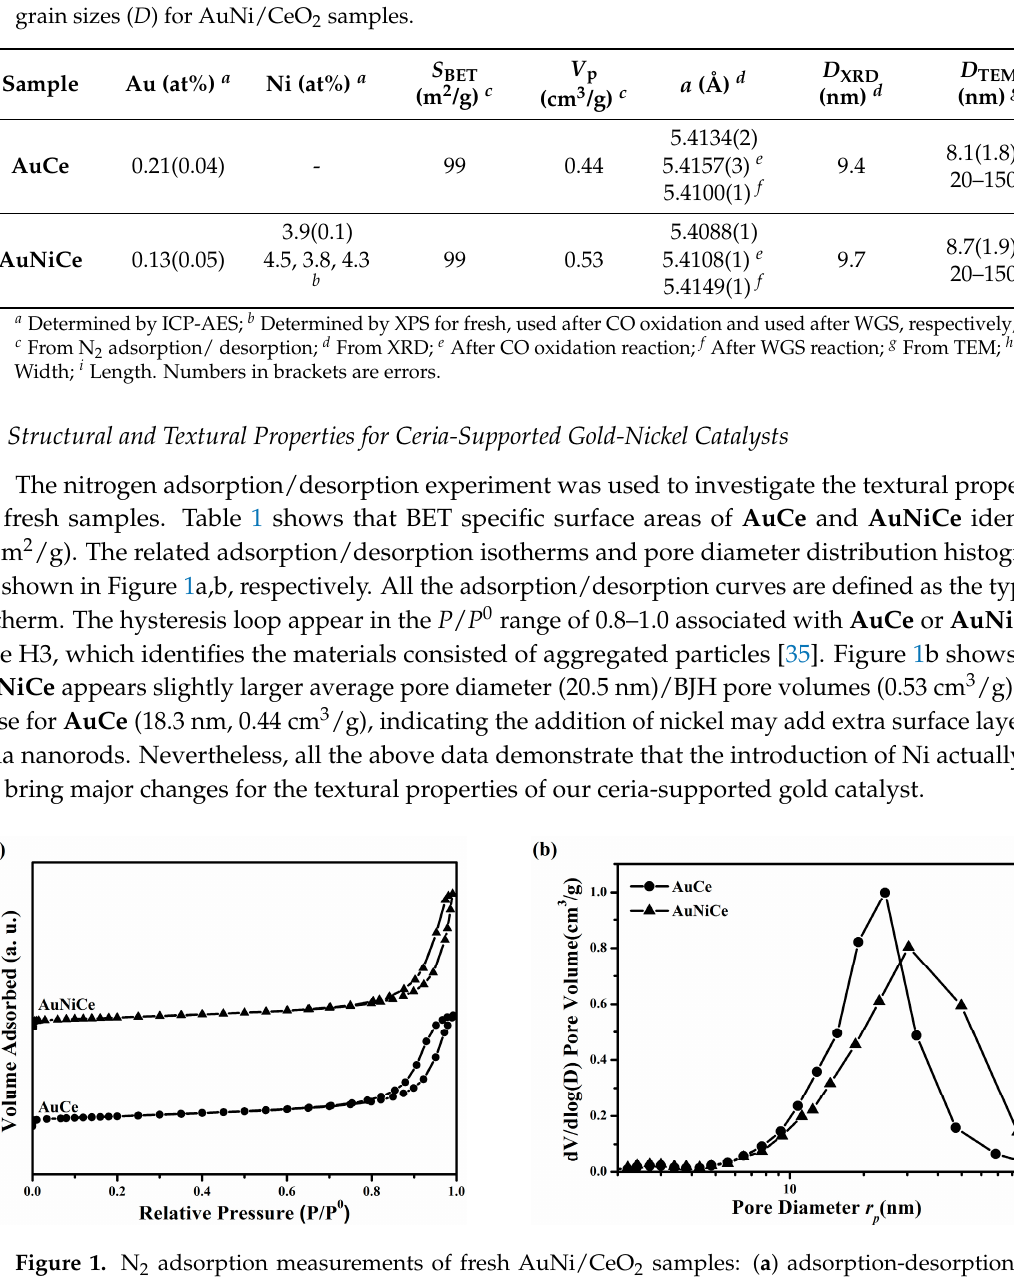
Table 1. Au and Ni bulk concentration, atomic ratios (Ni/(Ni + Ce)) on the surface, BET Specific surface areas ( S BET ), BJH (Barett-Joyner-Halenda) pore volume ( V p ), lattice constants ( a ) of CeO 2 , averaged grain sizes ( D ) for AuNi/CeO 2 samples.